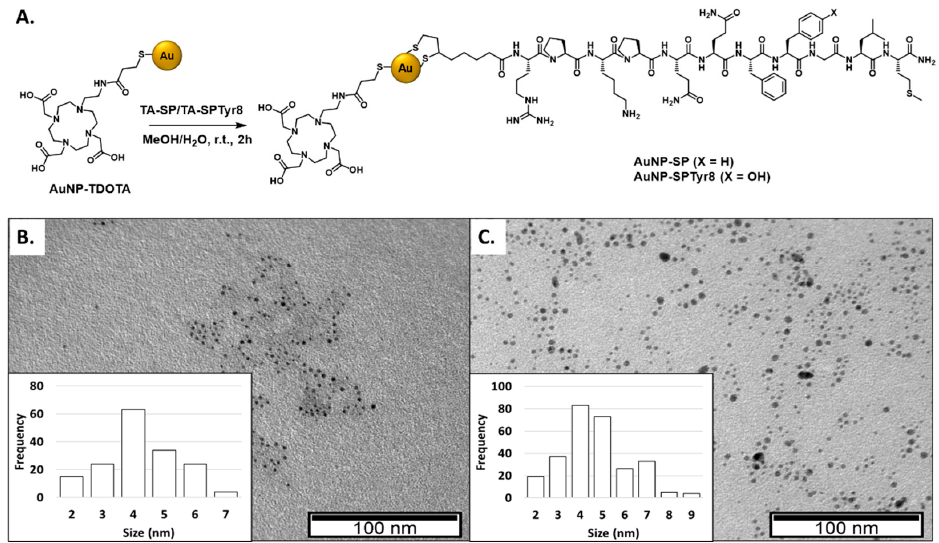
Figure 1. Functionalization of AuNP-TDOTA with the SP peptides to afford AuNP-SP and AuNP- SPTyr8 ( A ). TEM images and corresponding size distribution histograms for AuNP-SP ( B ) and AuNP-SPTyr8 ( C ).